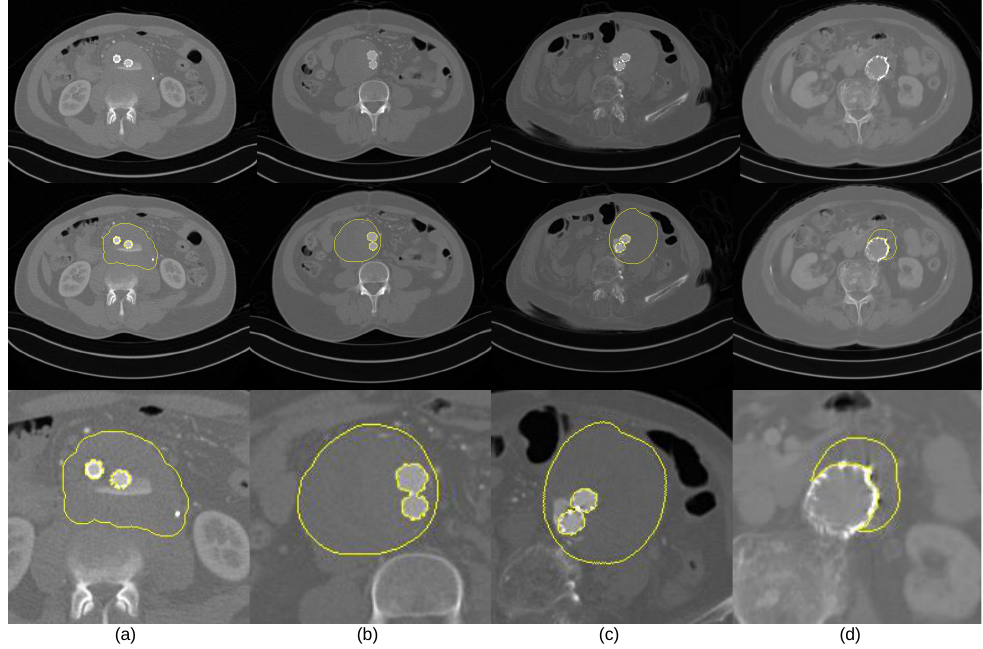
Figure 1. Thrombus ROIs of a CTA image volume. The first row shows four images from different patients, the second row is the thrombus ROIs (annotated by yellow color), and the third row is a focused view of the thrombus